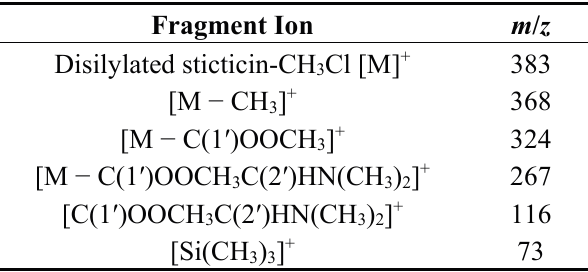
Figure 7. Mass spectrum of disilylated sticticin. Table 2. MS data of disilylated